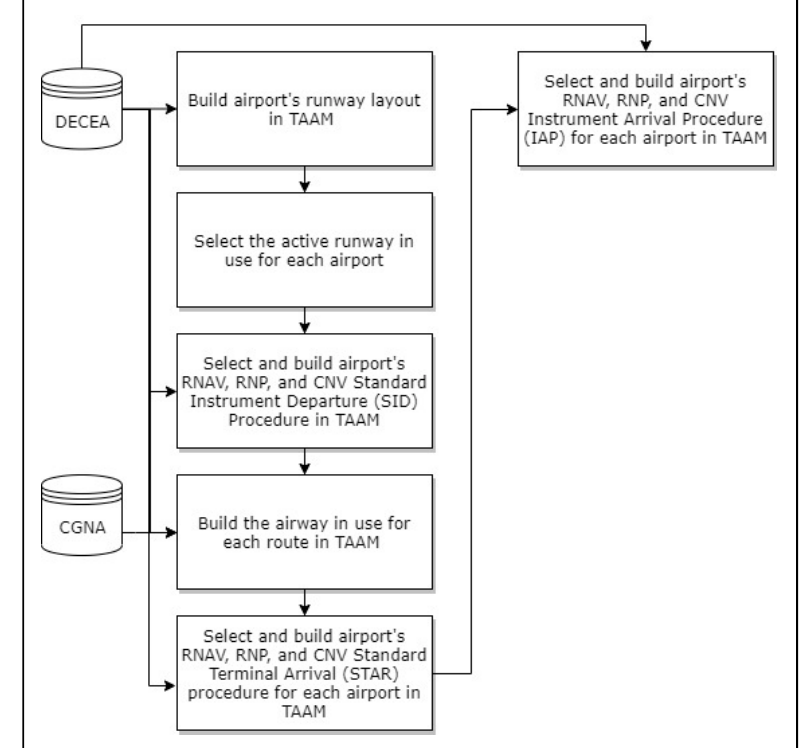
Figure 3. Flow chart for building TAAM scenarios. Source: The authors .